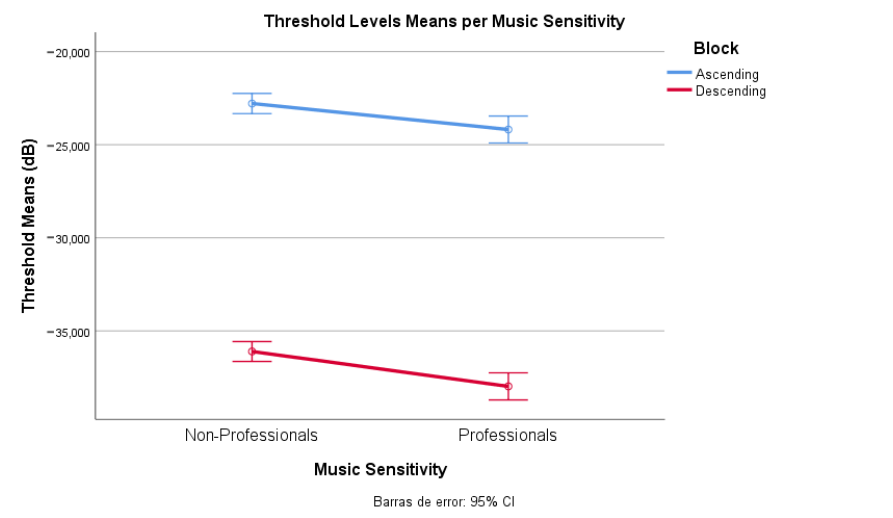
Figure 3. Average threshold levels difference of music sensitivity.